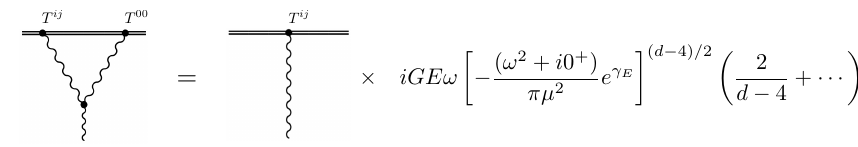
Figure 2 . Universal ultraviolet structure of the hereditary effects (in the far zone) at leading order in the GEω expansion. The wavy and (doubly) solid lines represent the gravitational field and binary system, respectively. The latter is described by the (near zone) stress-energy tensor T µν . Only tail terms contribute to the (ultraviolet) divergence [36]. The ellipses contain finite terms in the d → 4 limit. See [64] for more